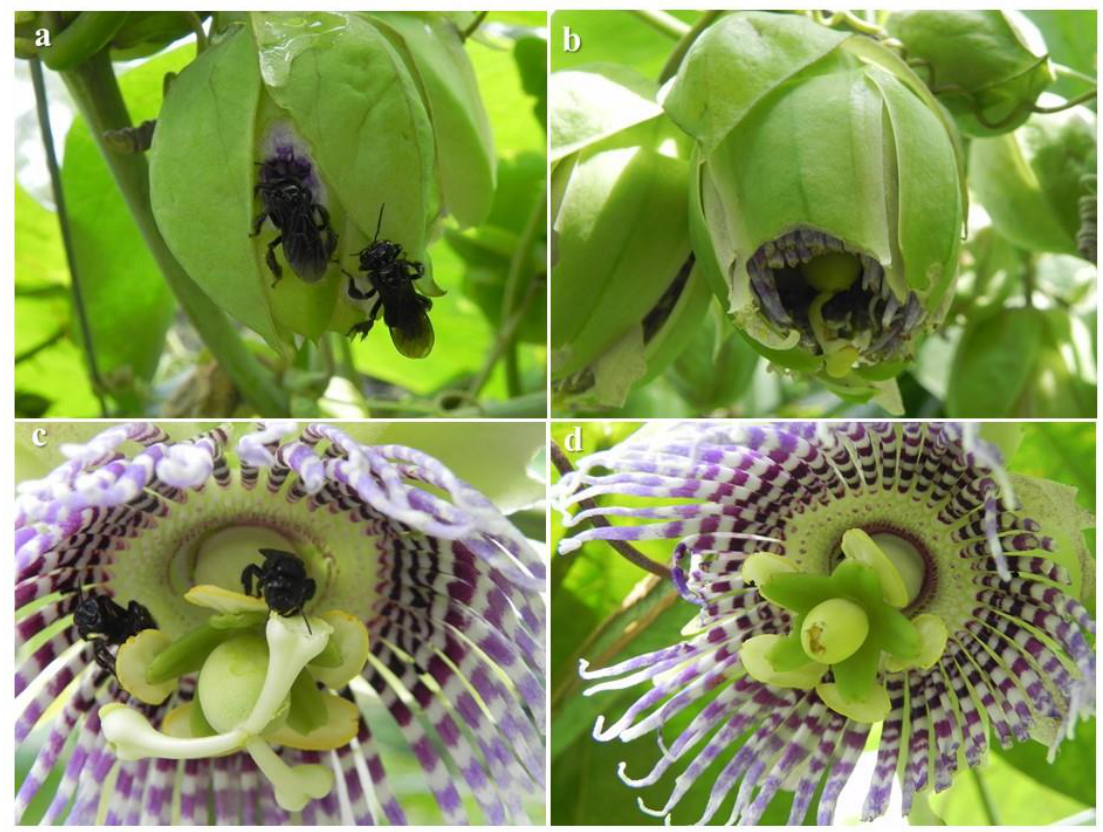
F IGURE 1. Damage caused by Trigona amalthea to granadilla flowers. Petals of flower-buds are perforated and cut away with the mandibles to extract mainly pollen (a, b). From open flowers, T. amalthea obtain nectar and pollen but can also continue damaging floral structures (c), causing loss of flower functionality as stigmas and styles can be totally destroyed